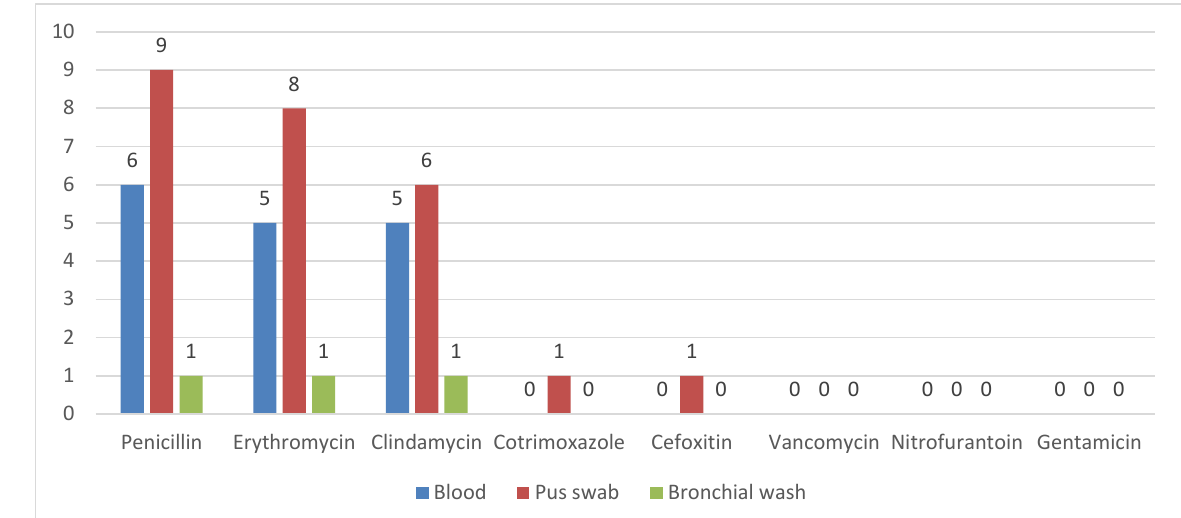
Fig. 4. Antibiotic resistance pattern of biofilm positive isolates in various samples.